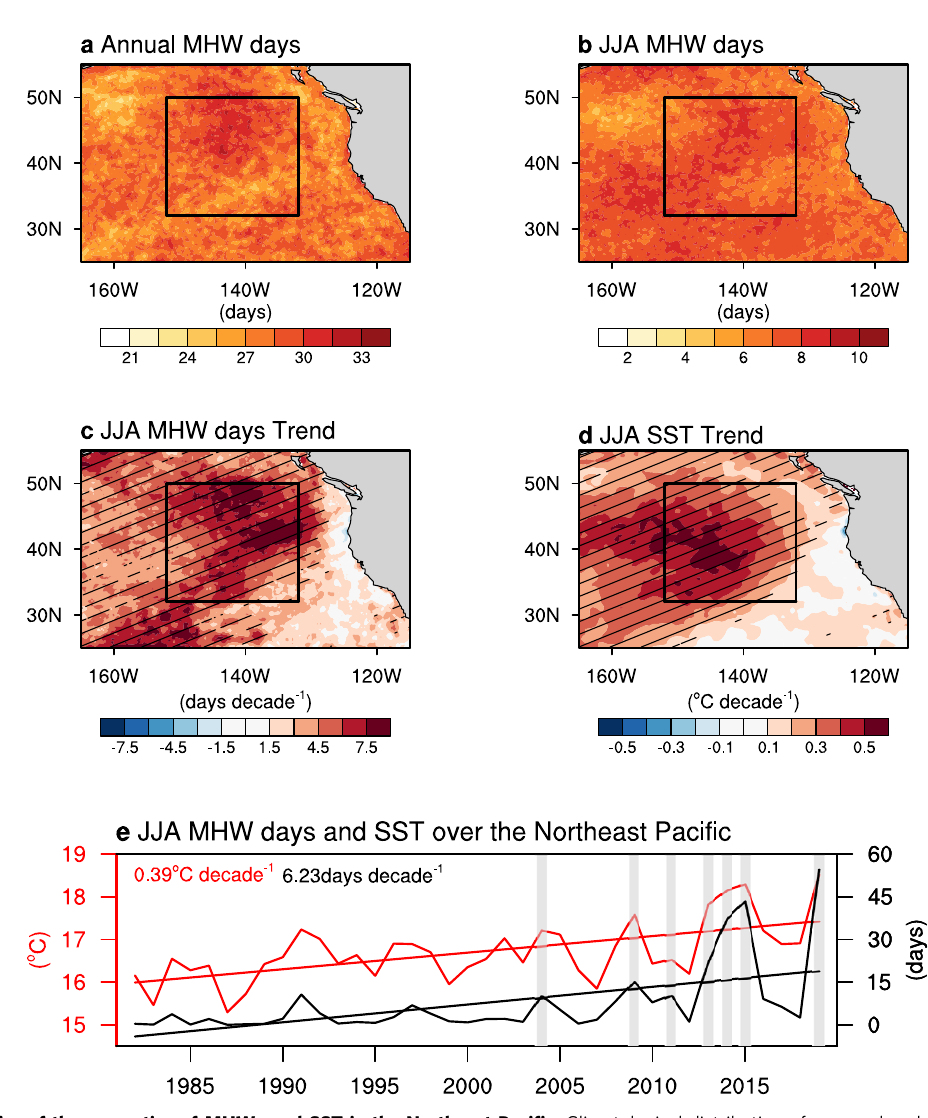
Fig. 1 Characteristics of the properties of MHWs and SST in the Northeast Paci fi c. Climatological distribution of a annual and b summer (June-July- August, JJA) count of MHW days (in days) for 1982 – 2019. Trend map of c MHW days (days decade − 1 ) and d SST (°C decade − 1 ) during JJA. Hatched regions in c and d indicate statistically signi fi cant values at the 90% con fi dence level based on a two-sided t test. The black box represents the area (32° – 50°N, 132° – 152°W) where SST and MHW days have been signi fi cantly increased. e Time series of mean SST (°C, red line) and MHW days (days, black line) during JJA averaged over the black box in a . Linear trends for 1982 – 2019 in each component are shown at the top left of the fi gure in e . Shade in gray in e denotes the years (2004, 2009, 2011, 2013, 2014, 2015, and 2019) when the MHW days during JJA were >10 days since the late